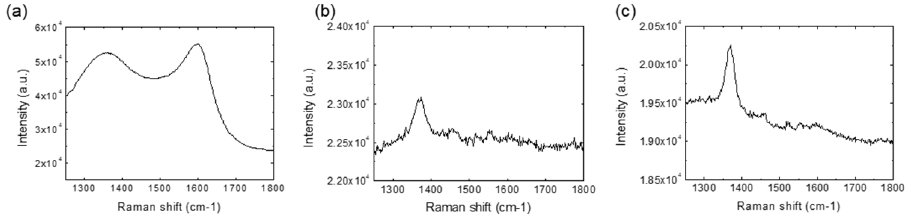
Figure A1. Raman spectrum of the synthesized h-BN at different temperatures: ( a ) 800 °C, ( b ) 900 °C, and ( c ) 1000 °C.